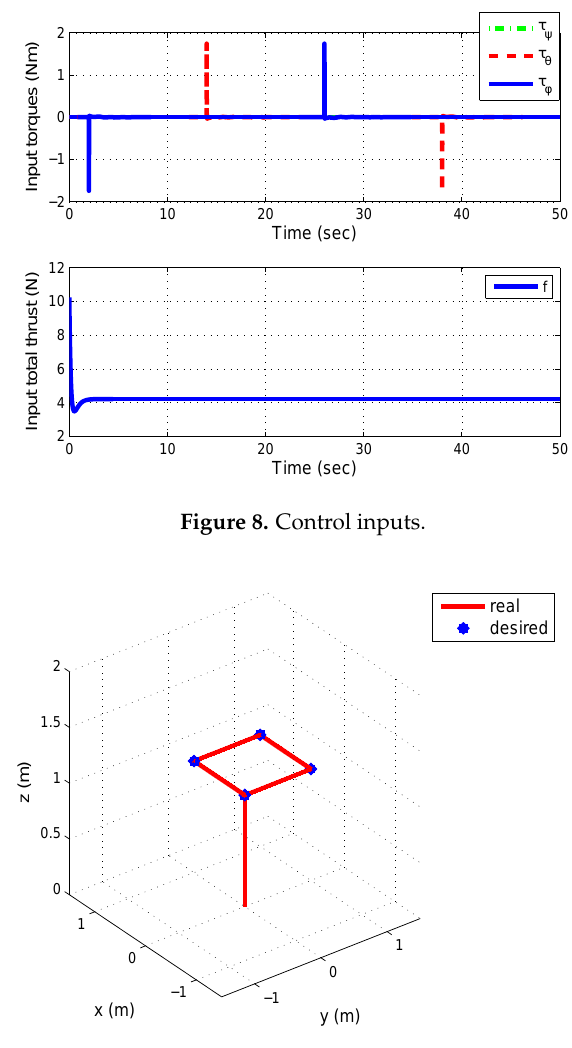
Figure 9. Three-dimensional